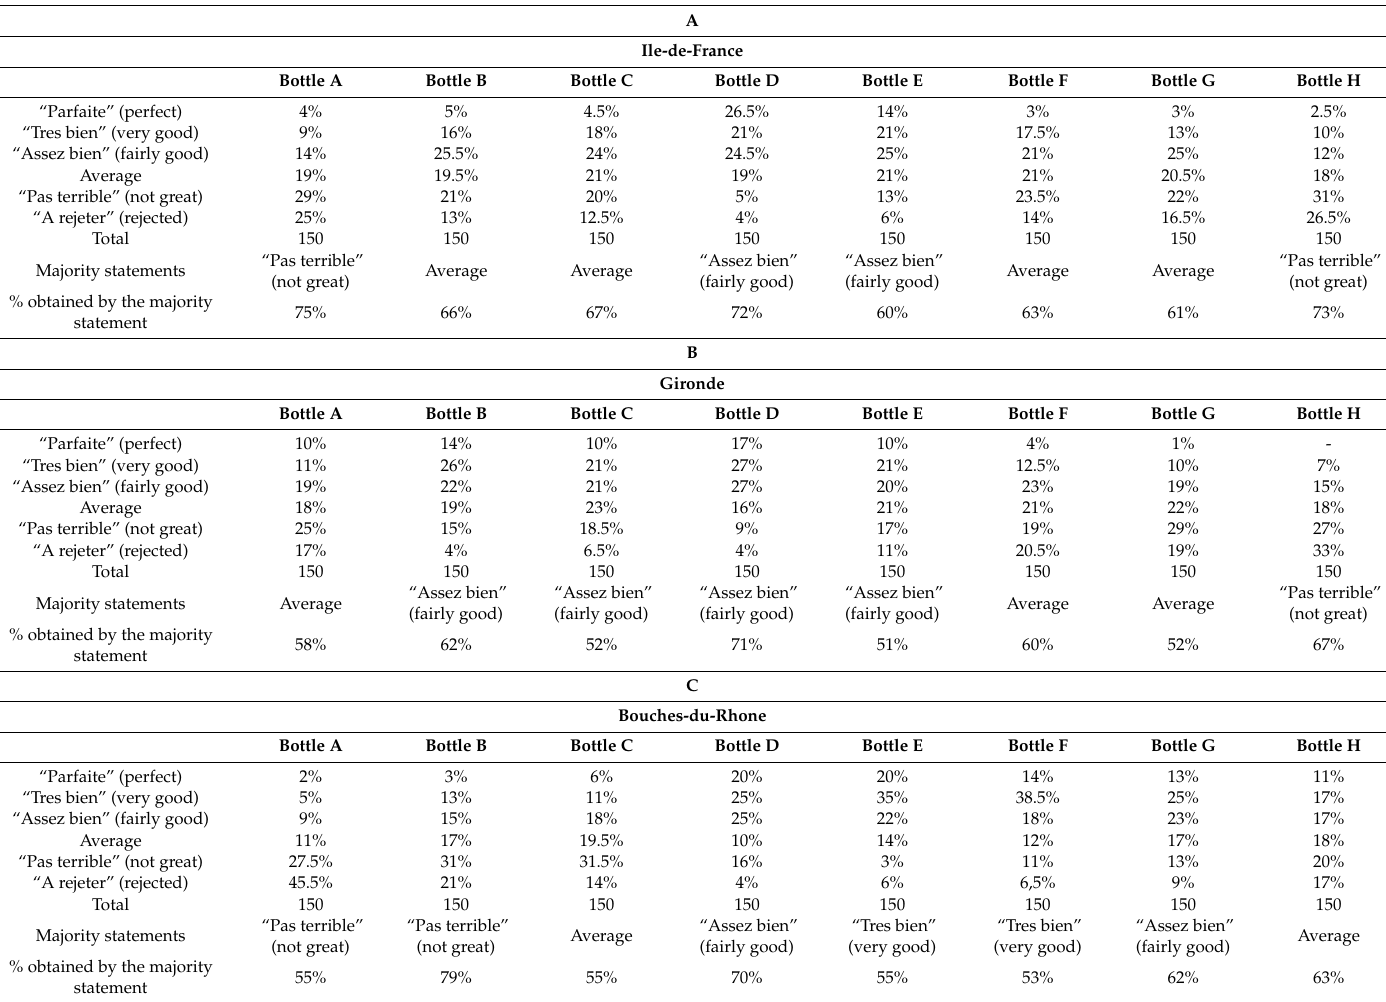
Table 4. Results for respondent preferences for the colour of rose wines using the Balinski and Laraki method (2011) for the Ile-de-France ( A ), Gironde ( B ) and Bouches-du-Rhone ( C )